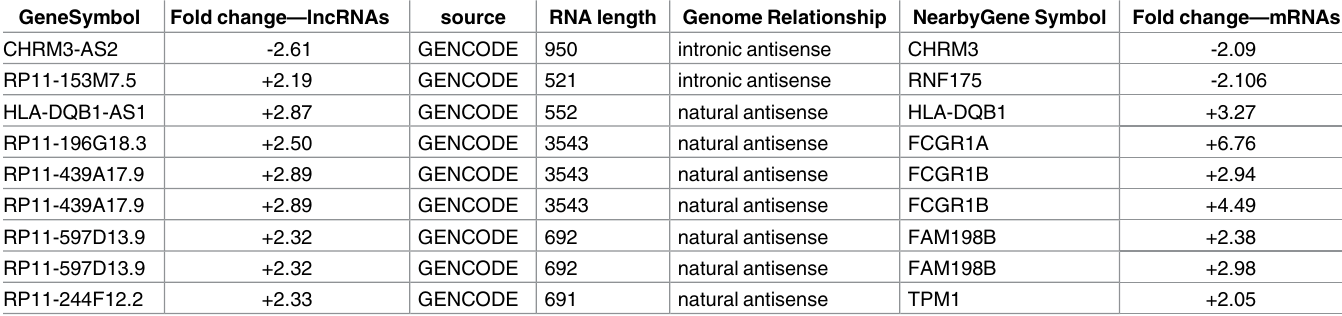
Table 2. Deregulated antisense lncRNAs and their associatedcoding